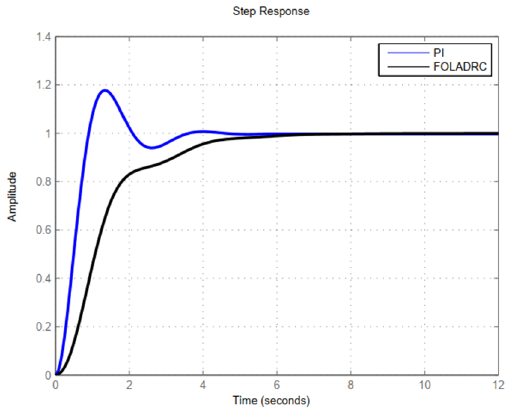
1 l  , Figure 7. Typical step responses of FOLADRC and PI control. The parameters are: l 1 = 1, β 1 = 20, 1